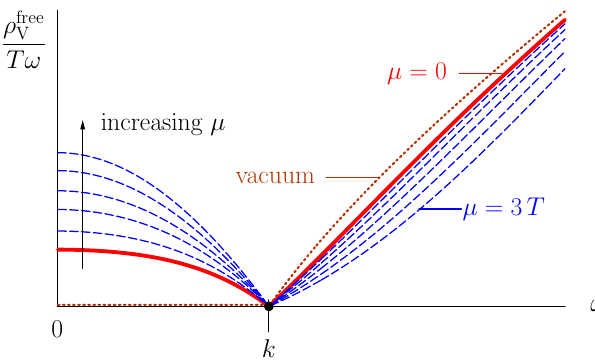
Figure 1. Sketch of the free spectral function ( α s = 0), with the µ = 0 result (solid) and the impact of µ > 0 also shown (dashed). The limit T , µ → 0 of eq. (3) is the vacuum result